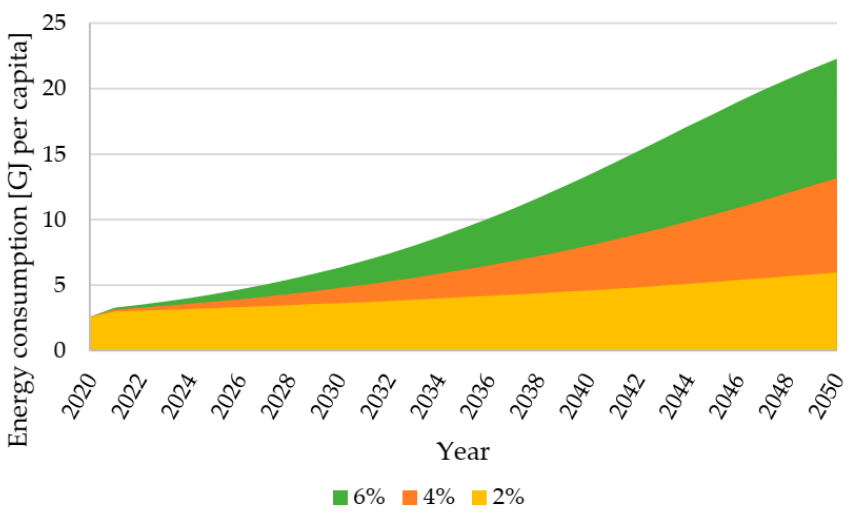
Figure 4. Total emissions per capita by varying GDPc.